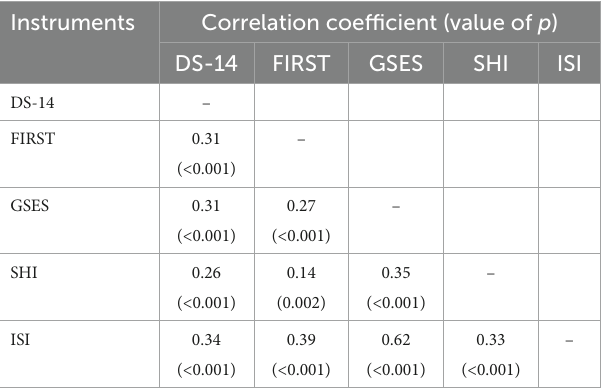
TABLE 3 Correlations between